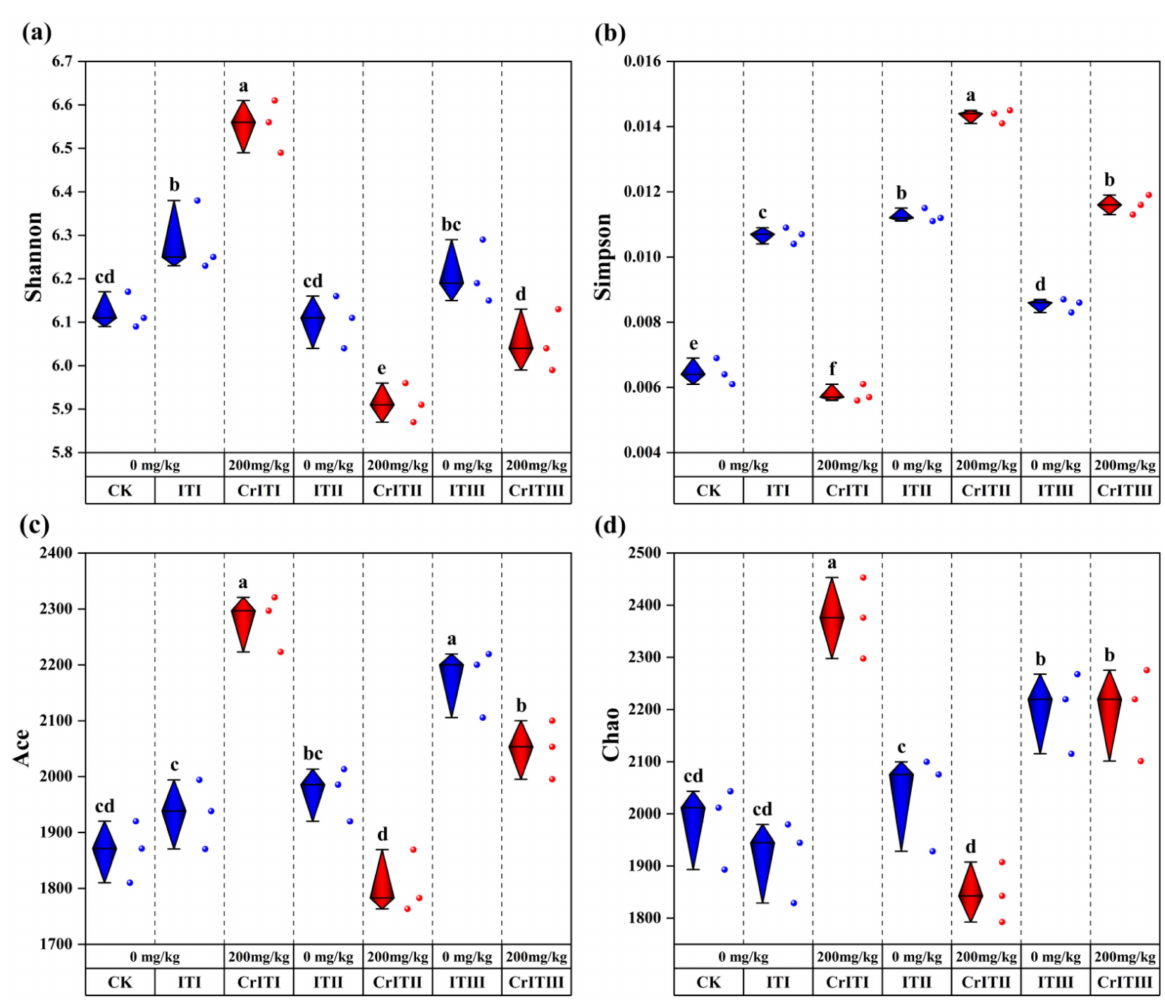
Figure 2. Rhizosphere microbial community diversity and abundance index of iris under Cr stress (( a ) Shannon index; ( b ) Simpson index; ( c ) Chao index; ( d ) Ace index). Data within the same followed by a string of the same lowercase letters are not significantly different ( p > 0.05). At the same time, a series of other letters show a significant difference ( p <